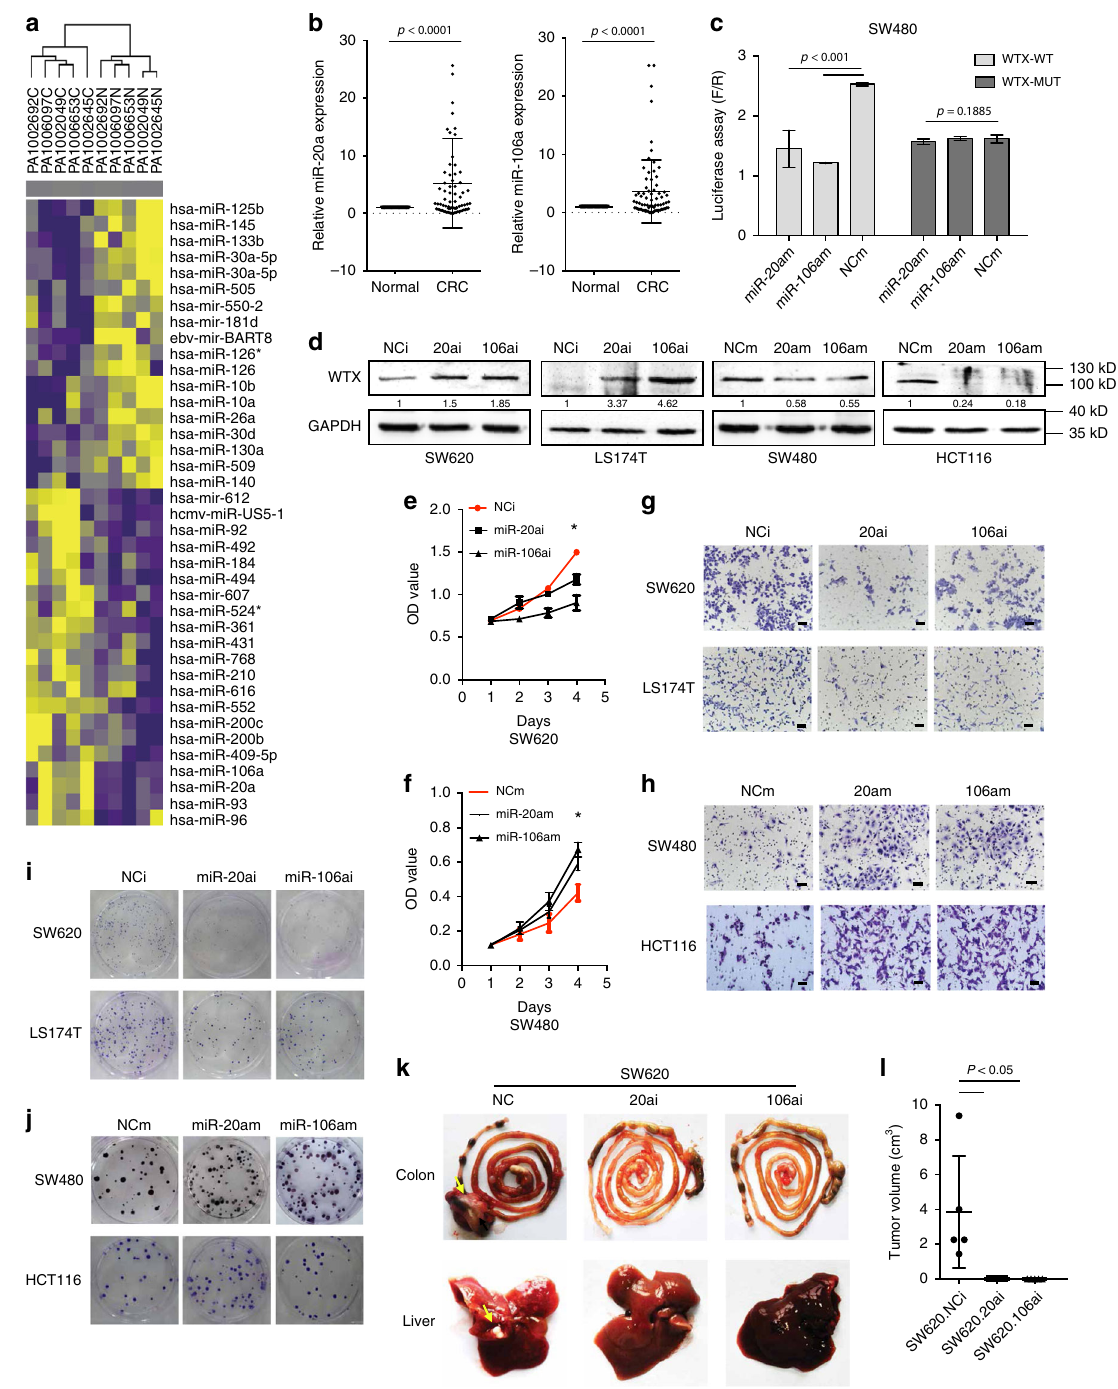
Fig. 5 Aberrant miR-20a/106a upregulation leads to WTX loss in CRC. a MicroRNA expression heatmap of CRC and matched adjacent normal mucosa tissues. b qRT-PCR analyzes miR-20a/106a expression in CRC and matched adjacent normal mucosa tissues. *** p < 0.0001, mean ± SEM. Two-sided paired t -test. c Luciferase activity assay explores WTX 3 ′ -UTR binding with miR-20a or miR-106a in control and SW480 overexpression cells. *** p < 0.0001, mean ± SEM. Two-tailed Student ’ s t -test. d IB analyzes WTX expression in indicated cells. e , f Cell proliferation analyzes in indicated cells. * p < 0.05, mean ± SEM. Two-tailed Student ’ s t -test. g , h Transwell cell migration analyzes in indicated cells. Scale bars, 200 μ m. i , j Colony formation analyzes in indicated cell lines. k Gross observation of mice orthotopic CRC tumors and livers. Each arrow pointed a tumor mass. i Quantitative analysis of mice orthotopic CRC tumors in control and miR-20a/106a inhibit SW620 cells. * p < 0.05, mean ± SEM, n = 6. Two-tailed Student ’ s t